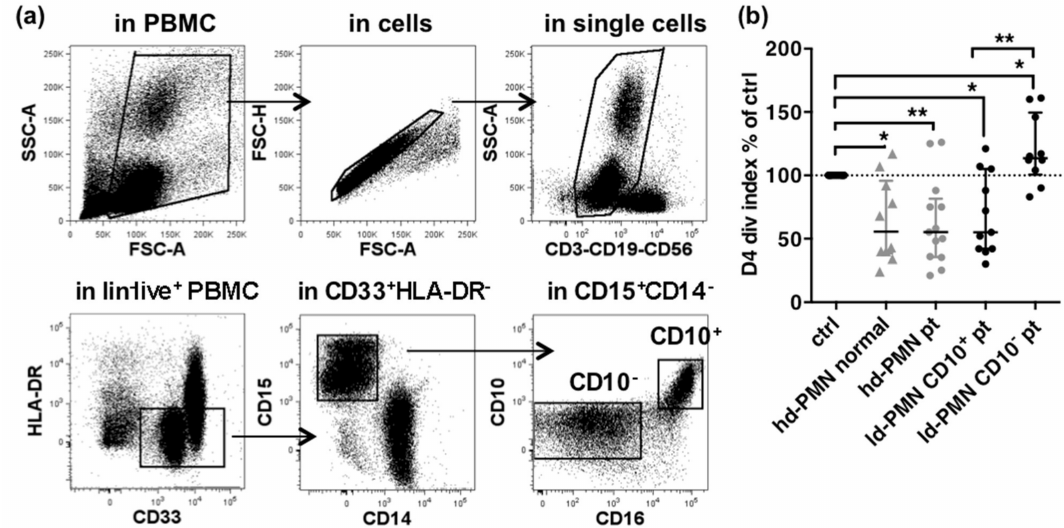
Figure 1. Suppression of T cells proliferation by high-density PMNs or PMN-MDSCs. ( a ) Sorting of PMN-MDSCs in PBMC. MDSCs are gated as CD33 + HLA-DR − cells within live CD3 – CD19 – CD56 – (lin − ) cells after exclusion of debris, doublets and dead cells. PMN-MDSCs are gated as CD14 – CD15 + cells in the MDSCs. CD10 + and CD10 – subsets are further gated in the PMN-MDSCs. ( b ) Inhibition of T cell proliferation in co-culture with high-density PMNs from healthy donor (hd-PMN normal, n = 10, grey triangles), high-density PMNs from patients (hd-PMN pt, n = 13, grey dots) or low-density PMNs subsets (CD10 + , n = 11, black dots; CD10 − , n = 10, black dots). Inhibition is shown as percentages of control T cell division index after a 4-days culture. Median and Inter-quartile-range (IQR). p -values of Wilcoxon matched pair-tests are indicated on top of pairs: *, p < 0.05; **, p <